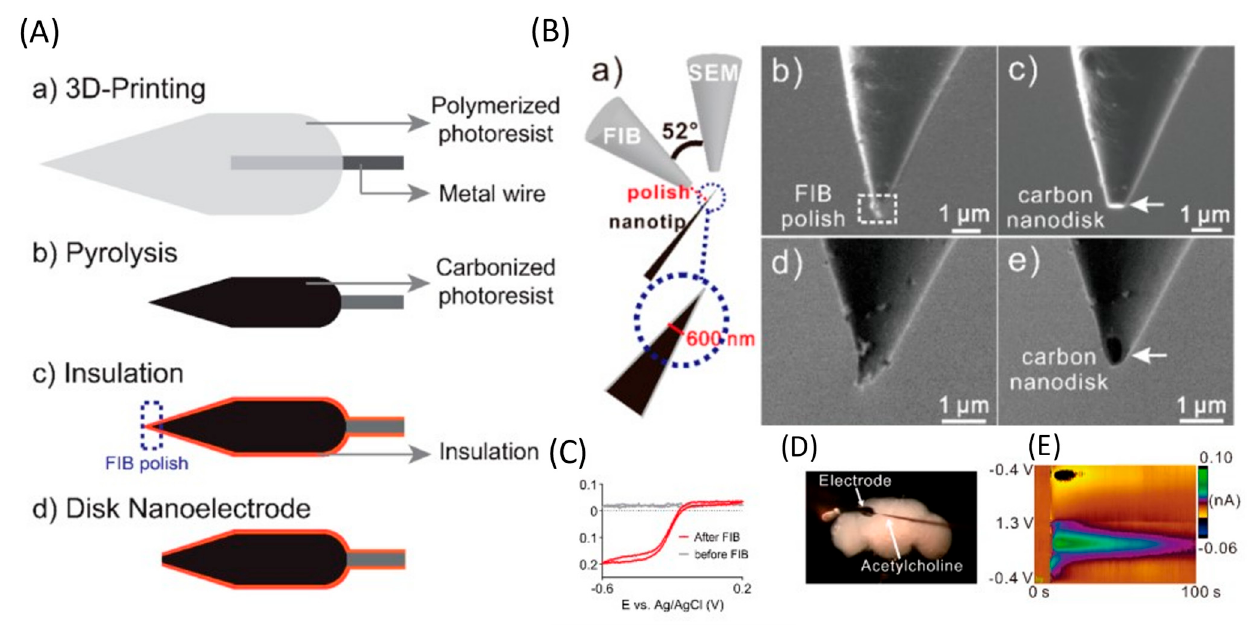
Figure 4. Application of 3D-printed electrodes. ( A ) Illustration outlining the fabrication of 3D-printed carbon nanoelectrodes. ( B ) Focused ion beam (FIB) polishing. ( a ) Illustration of the sample setup. The FIB detector is vertical to the nanotip sample, and the SEM detector has an angle of 52° to the FIB detector. FIB detector view ( b ) before and ( c ) after FIB polishing. SEM detector view ( d ) before and ( e ) after FIB polishing. ( C ) CV of the nanoelectrodes before and after FIB polishing in 10 mM Ru(NH 3 ) 6 Cl 3 . Scan rate = 100 mV s -1 . ( D ) Microscopy image of the adult brain with the 3D-printed nanoelectrode and a micropipette loaded with acetylcholine. ( E ) False color plot of DA detected after acetylcholine (2 pmol) stimulation. Reproduced from [72], copyright 2020 American Chemical Society.